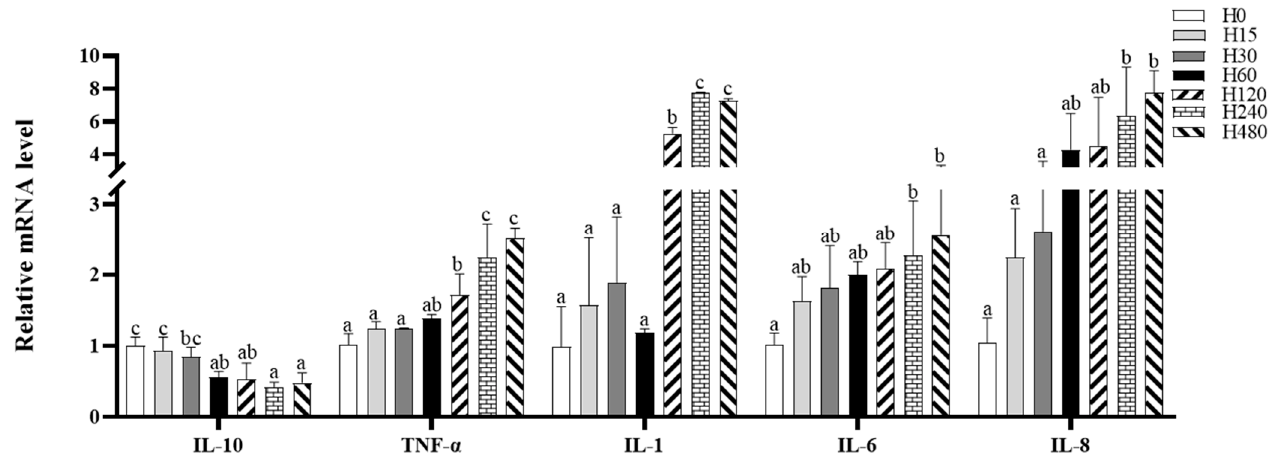
Figure 1. Intestinal inflammation-related gene expression of striped catfish fed with experimental diets. Values in each column with different superscripts represent significant differences ( p < 0.05).